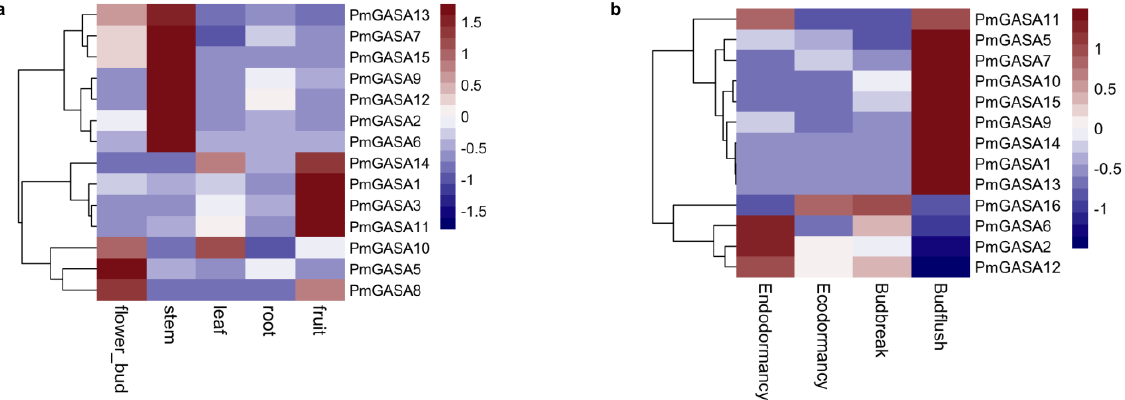
Figure 6. Expression analysis of PmGASA genes across different organs and during floral bud development in P. mume . ( a ) Expression profile of PmGASAs in flower bud, leaf, root, and fruit tissues. ( b ) Expression profile of PmGASAs during four developmental stages of floral bud break. Hierarchical clustering was used to compare the gene expression levels of PmGASAs across different samples, with highly expressed genes shown in red and weakly expressed in blue.